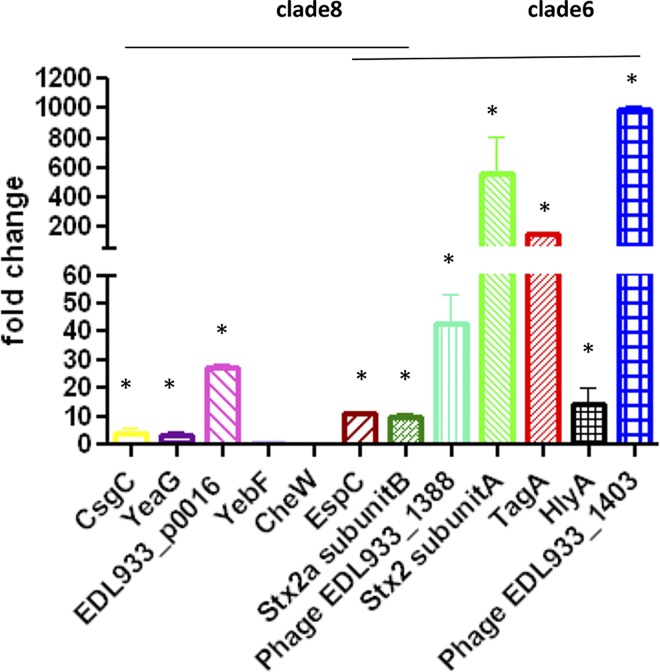
Comparison of the differential (clade 6/8 strain vs. EDL933) gene expression ratios of selected genes of E. coli O157:H7, obtained by RT-qPCR of RNA from bacteria grown in vitro.The bars indicate the fold change of Rafaela II (clade 8)/EDL933 or 7.1 Anguil (clade 6)/EDL933 for three independent biological replicates, for triplicate, and the error bars indicate the standard deviations. The values of gene expression in clade 8 or clade 6 strain were significantly different of those in EDL933, as determined by fgStatistic software(* p value < 0.05).